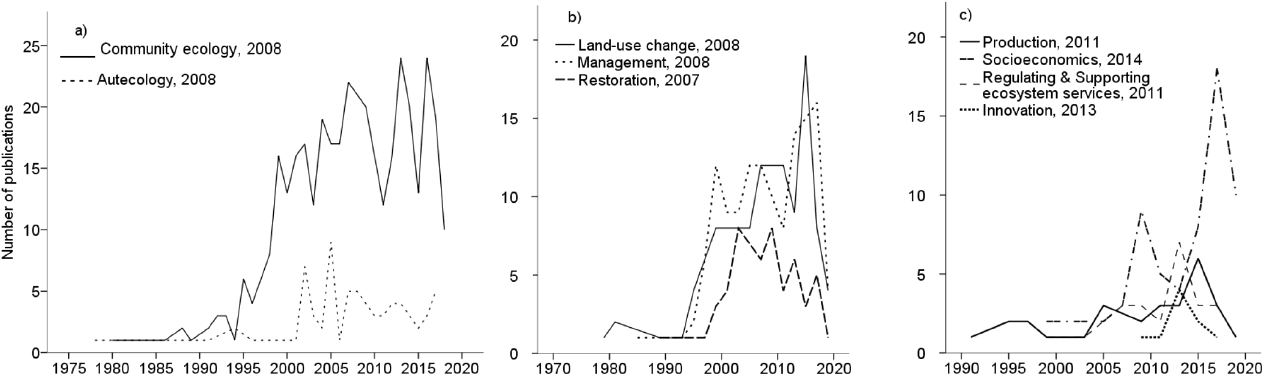
Fig. 4 . The time line of the research aspects as they appear in the research literature concerning semi-natural habitats in the boreal region. Because of small values and for clarity, the socioeconomic aspects (socioeconomics, policy, cultural ecosystem services) are pooled as Socioeconomics. The mean publication year indicates the peak publication period for each aspect. Note that the panels differ in the x- and y-axis scales.